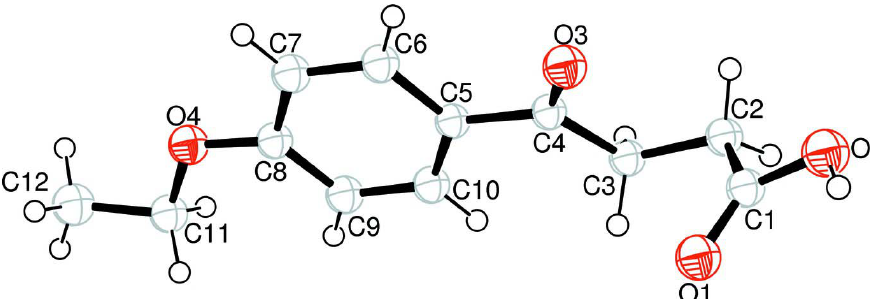
Figure 2 A partial packing diagram. Hydrogen bonds are shown as dashed lines.